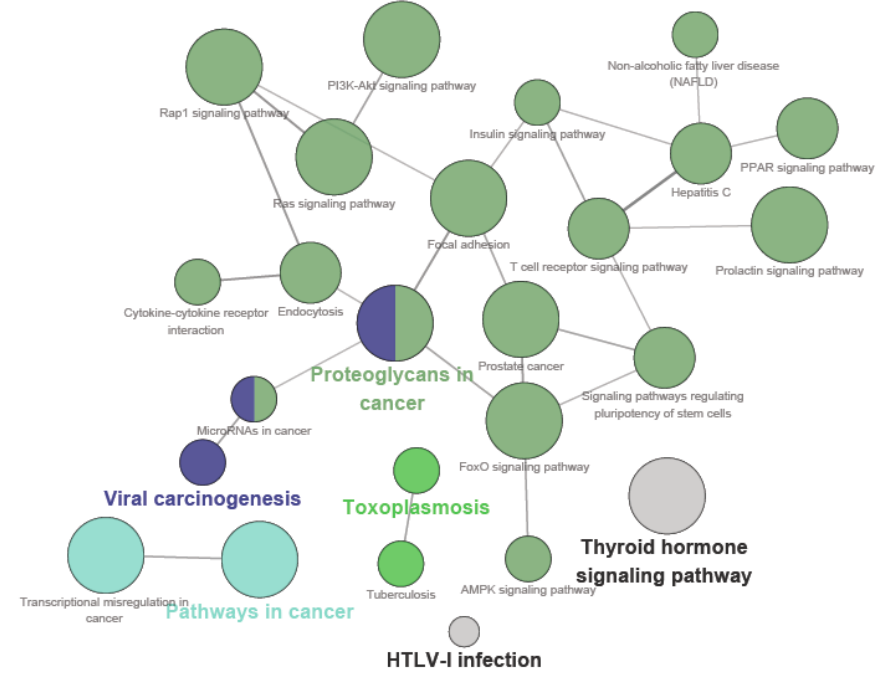
Figure 3. Pathway grouped network for the candidate targets of carainterol A.